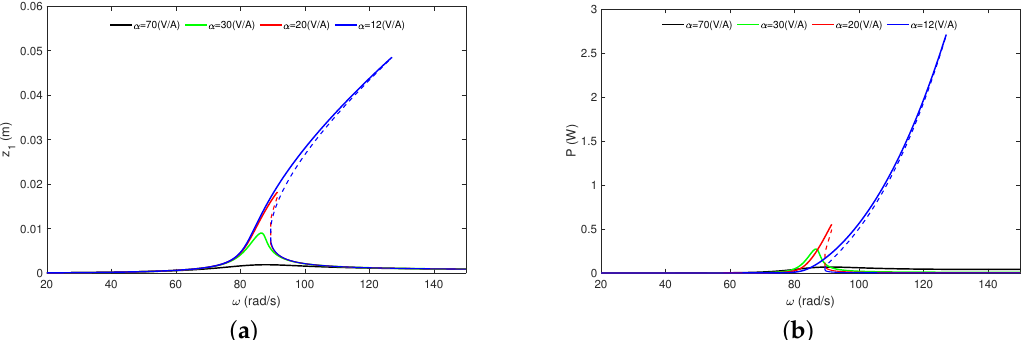
Figure 11. Analytical HBM results. Magnet’s resonance curves ( a ) and the recovered power ( b ) under the electromechanical coupling coefficient. The results have been calculated for Q = 0.6 mm and R = 2 k Ω . The results have been obtained from Equations (27) and (28). The dashed line means unstable solution obtained from